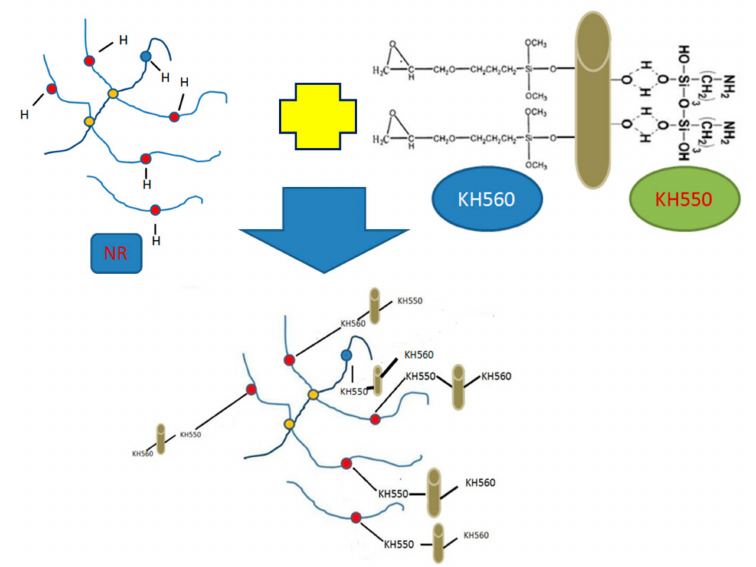
Figure 11. Coupling mechanism of KH550/KH560 with BFs.